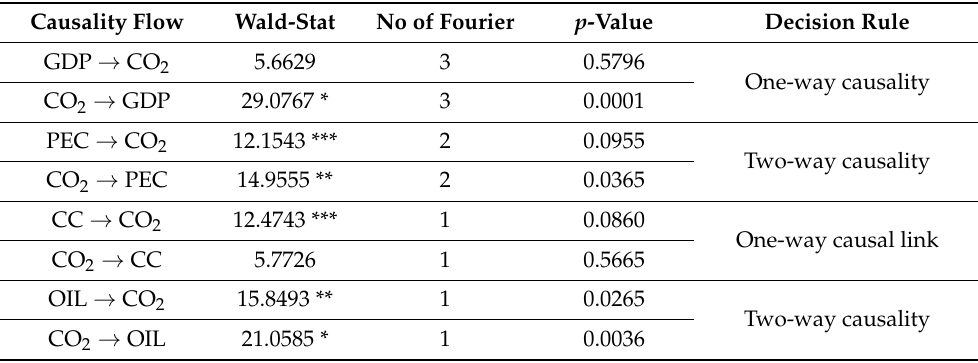
Table 9. Gradual shift causality